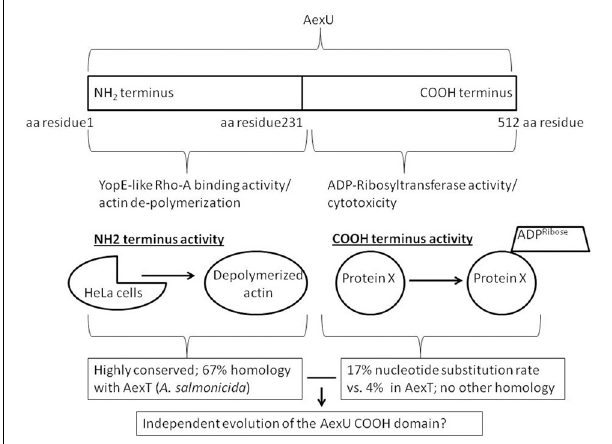
FIGURE 1 | The bifunctional AexU effector protein. The two independent activities of AexU are localized on either the NH2- or the COOH-termini. This allows for the possibility of an independently evolving COOH-terminal